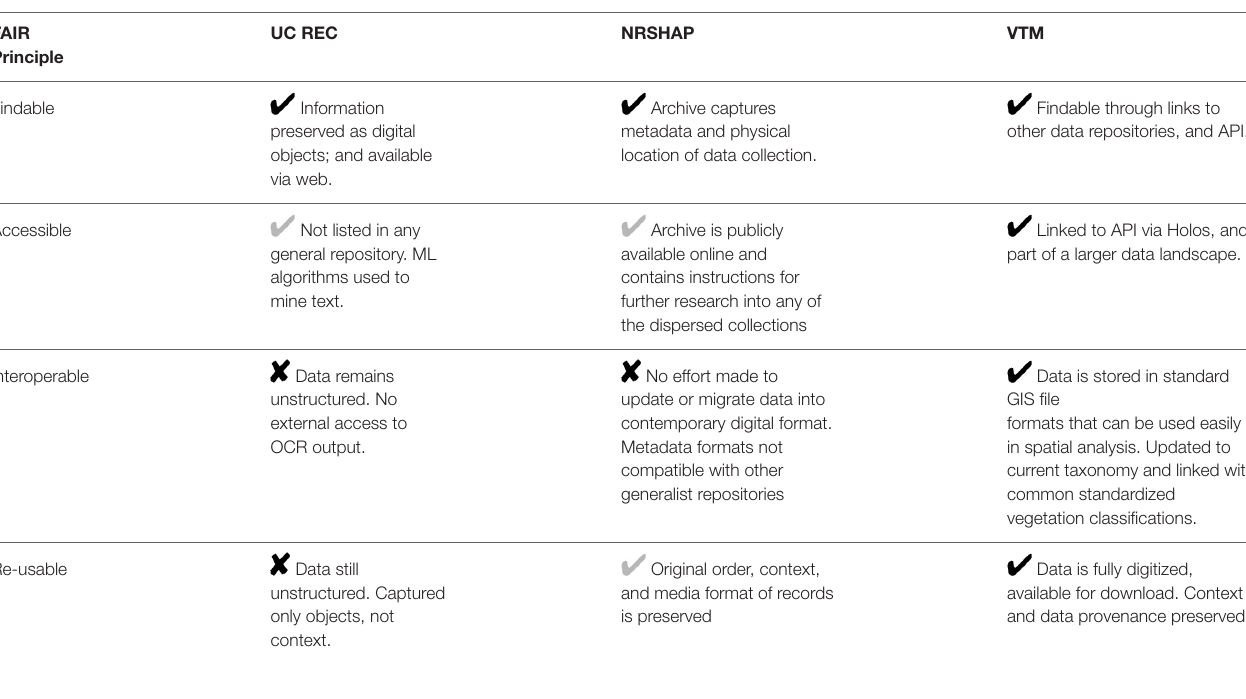
TABLE 1 | Evaluation of three case studies according to FAIR data management principles; = successful; = partially successful; and = not